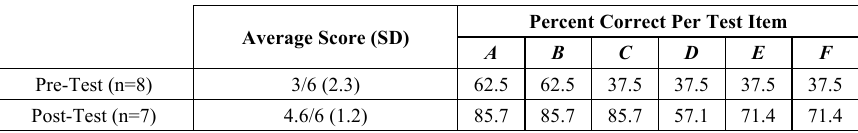
Table 5. Student scores (percent) to qualitative test